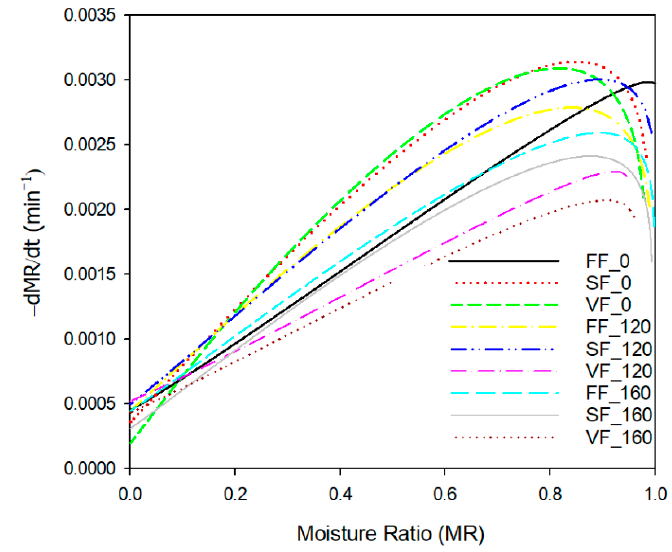
Figure 4. Drying rate curves of freeze-dried apples with different PEF treatment and freezing meth-